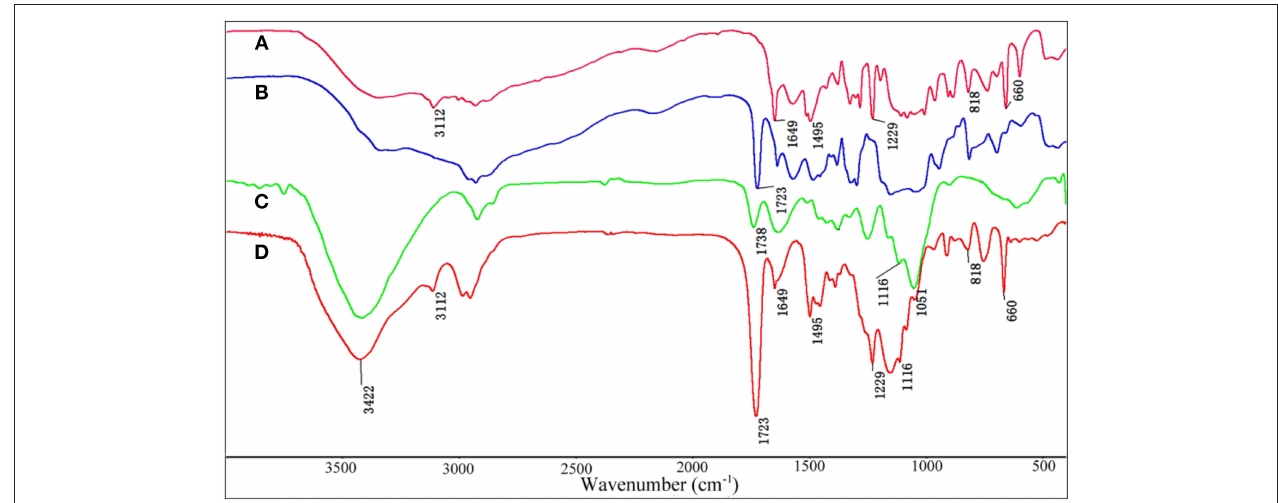
FIGURE 1 | FTIR spectra of (A) VIM, (B) EGDMA, (C) KF and (D) KF@VIM/EGDMA.